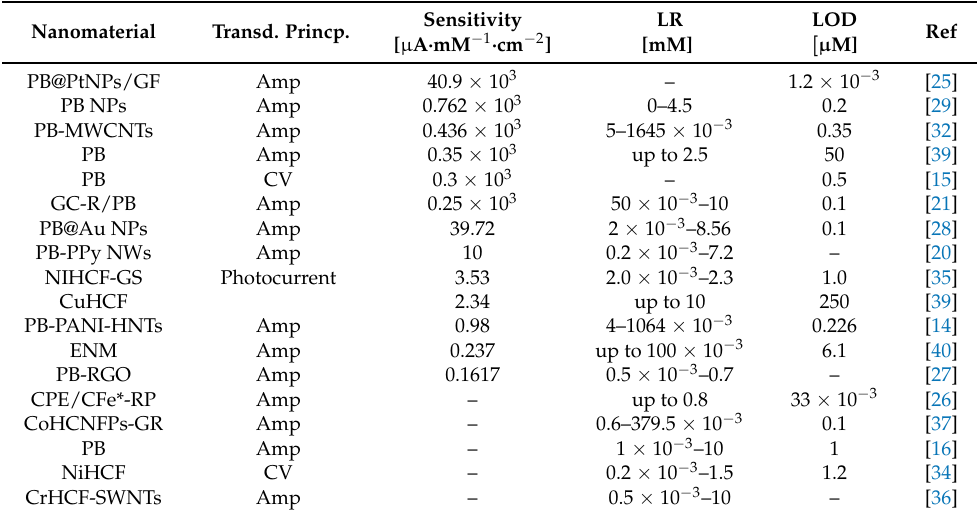
Table 1. Metal hexacyanoferrates b